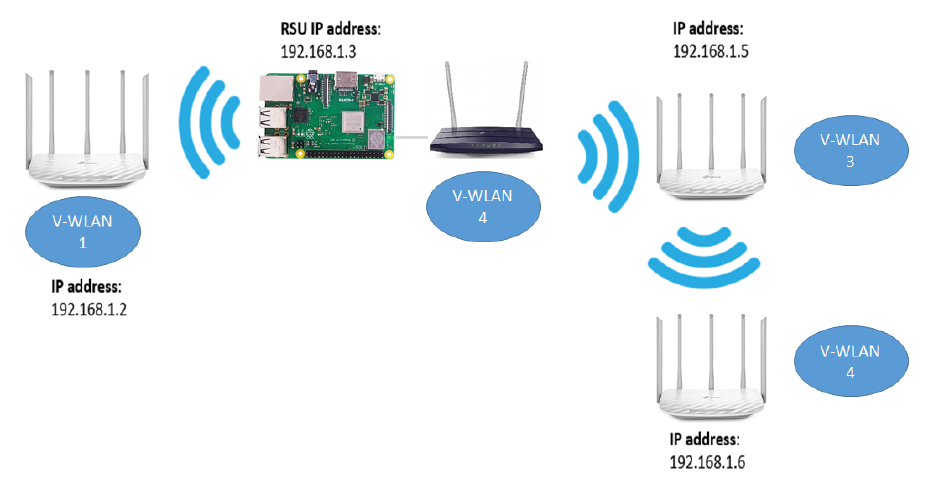
Figure 2. Full Network topology with Raspberry Pi as RSU and TP-Links as APs.